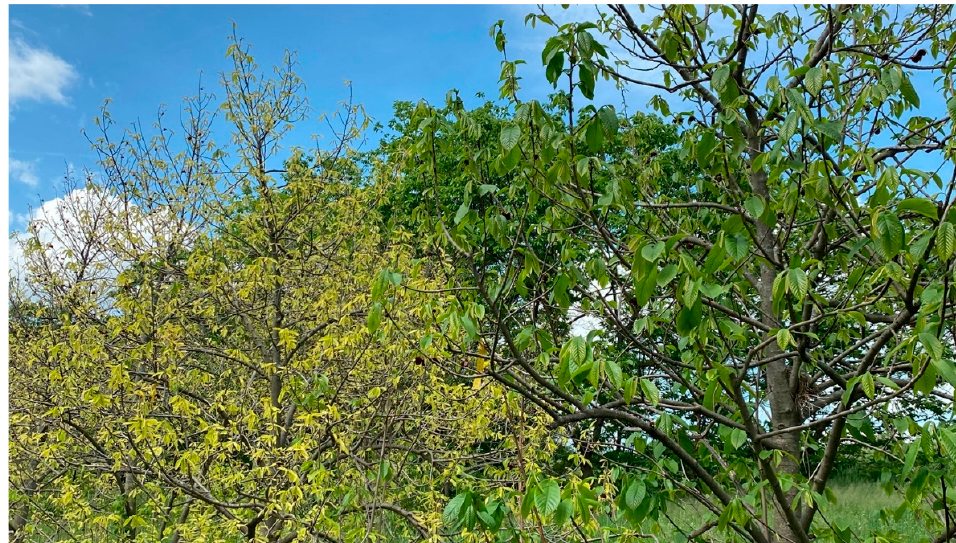
Figure 1. Symptomatic (left) and asymptomatic (right) pawpaw trees in an experimental orchard in Lansing, NY. The photo was taken in May 2022.